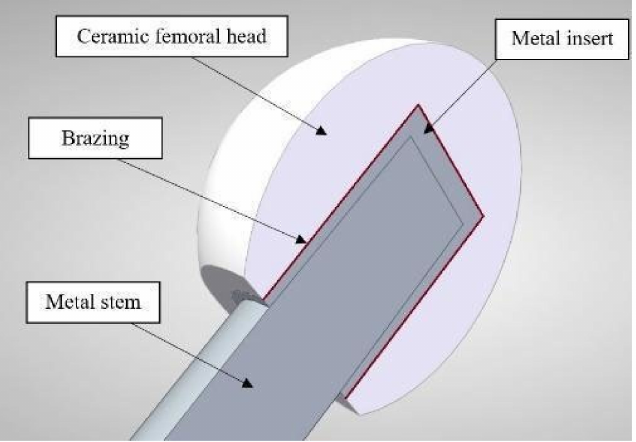
Figure 1. Design of a hip joint endoprosthesis femoral head with an integrated metal